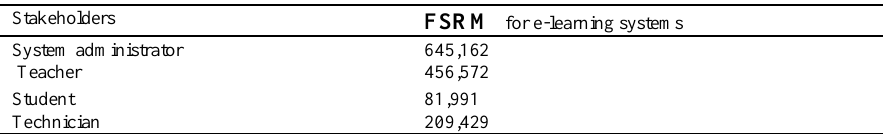
Table 6: Mean Failure Cost based on an e-learning functional